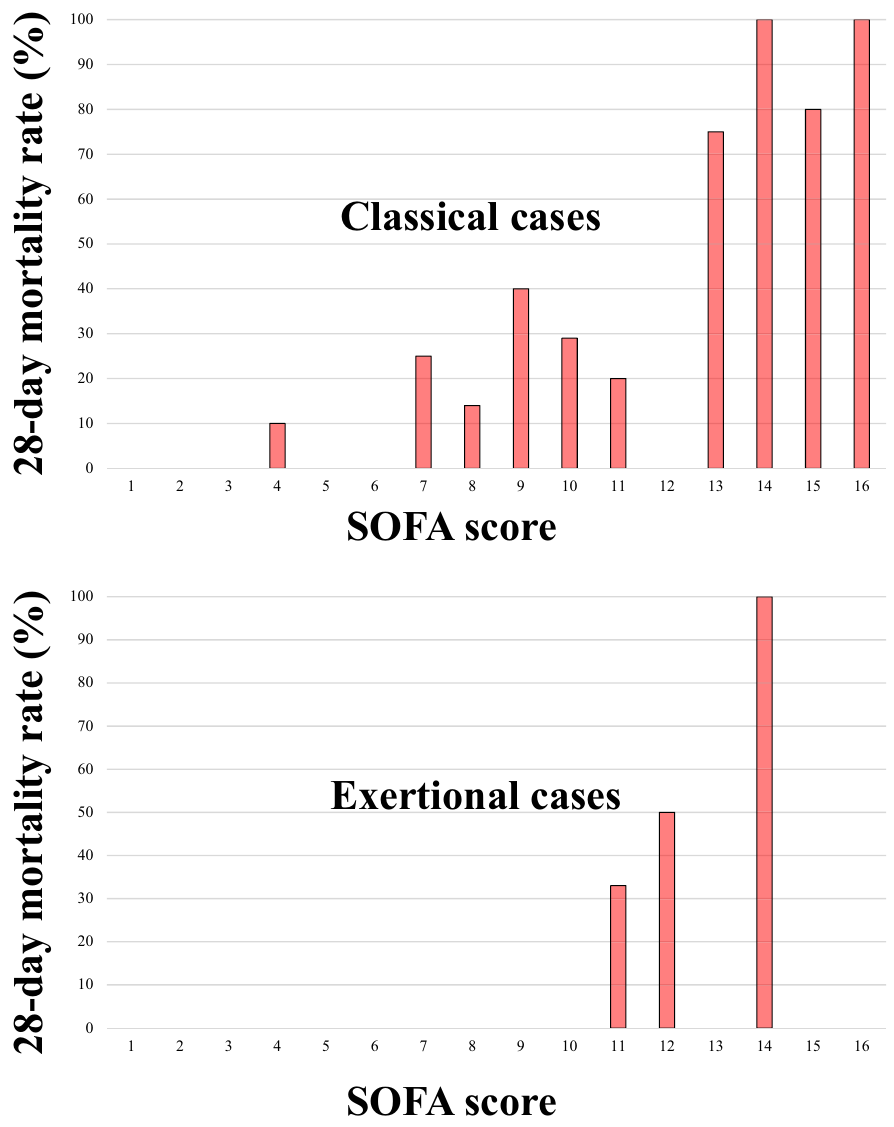
Figure 2. Bar graph of 28-day mortality rates according to SOFA scores in classical and exertional cases the mortality rate was correlated with the SOFA score, with a dramatic increase in mortality in patients with a SOFA score of ≥ 13 from both bar graphs. SOFA, Sequential Organ Failure